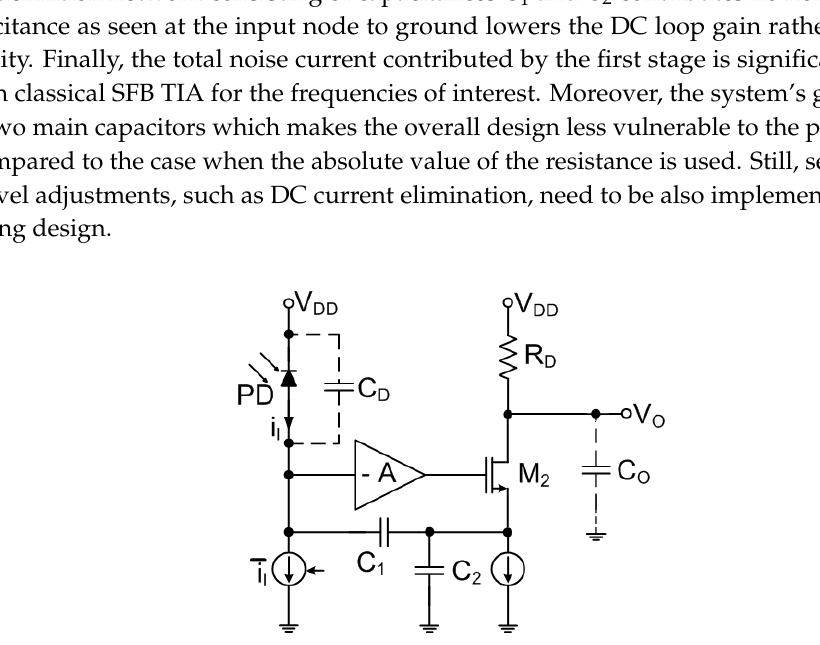
Figure 7. TIA with a capacitive-feedback